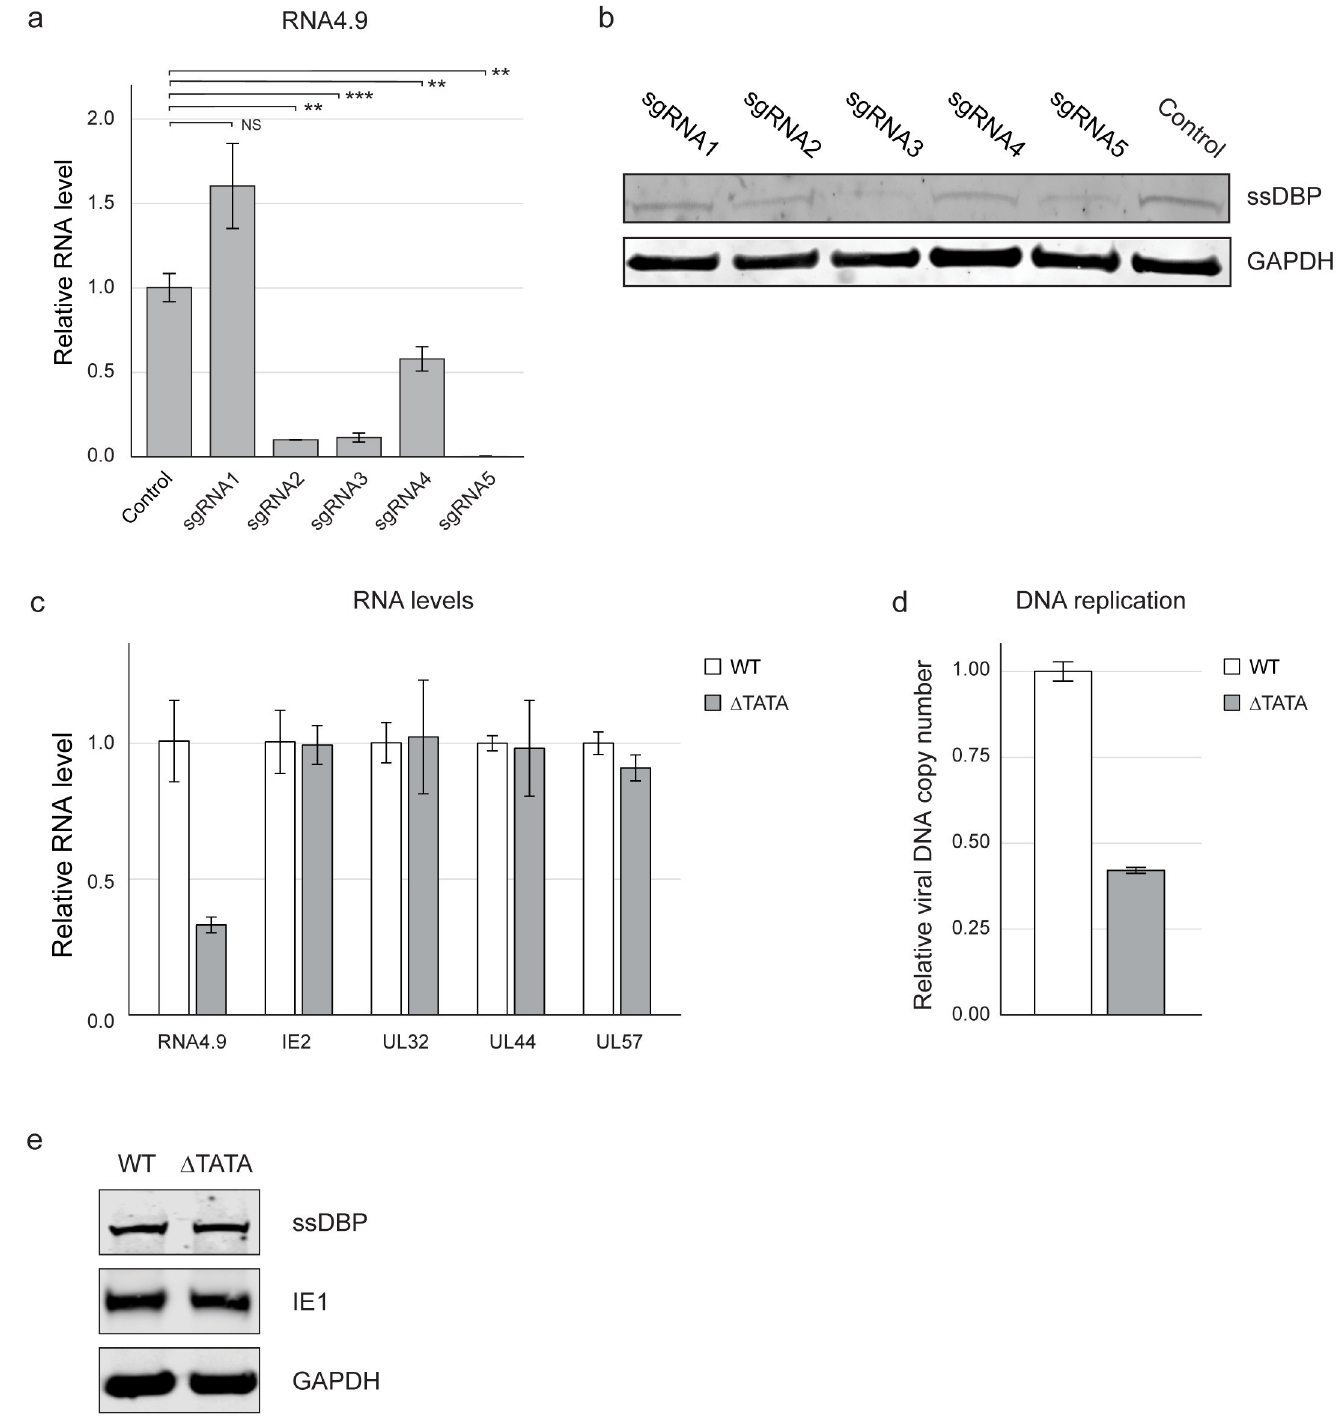
Fig 6. ssDBP levels and viral DNA replication are strongly correlated with RNA4.9 transcription. a-b) Fibroblasts expressing CAS9 and either a control sgRNA or one of five different sgRNAs targeting RNA4.9, as indicated, were infected with HCMV Merlin strain (MOI = 3), treated with PFA and harvested at 48 hpi. a) Relative RNA4.9 levels were quantified using RT-qPCR and normalized to the cellular ANXA5 transcript. b) ssDBP was detected by immunoblot analysis and GAPDH was used as a loading control. c-e) Fibroblasts infected with the Δ TATA or the parental WT Merlin strain (MOI = 1) were harvested at 48 hpi. c) Fibroblasts were treated with PFA during infection. Relative expression levels of indicated viral genes were quantified using RT-qPCR and normalized to the cellular ANXA5 transcript. d) Relative viral DNA levels were measured using qPCR using UL44 primers, and normalized to the cellular gene B2M. e) ssDBP, IE1/2 and the UL44 protein were detected by immunoblot analysis. Human GAPDH was used as loading control. https://doi.org/10.1371/journal.ppat.1008390.g006 PLOS Pathogens| https://doi.org/10.1371/journal.ppat.1008390 April 15,